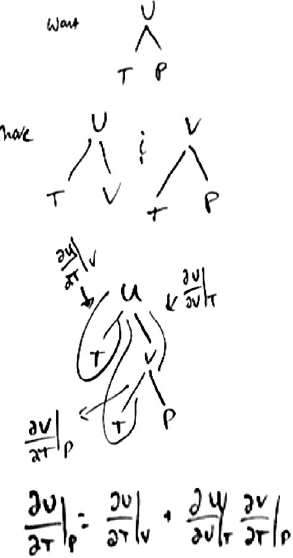
FIG. 10. Student 4 ’ s tree diagram approach to derive the partial derivative